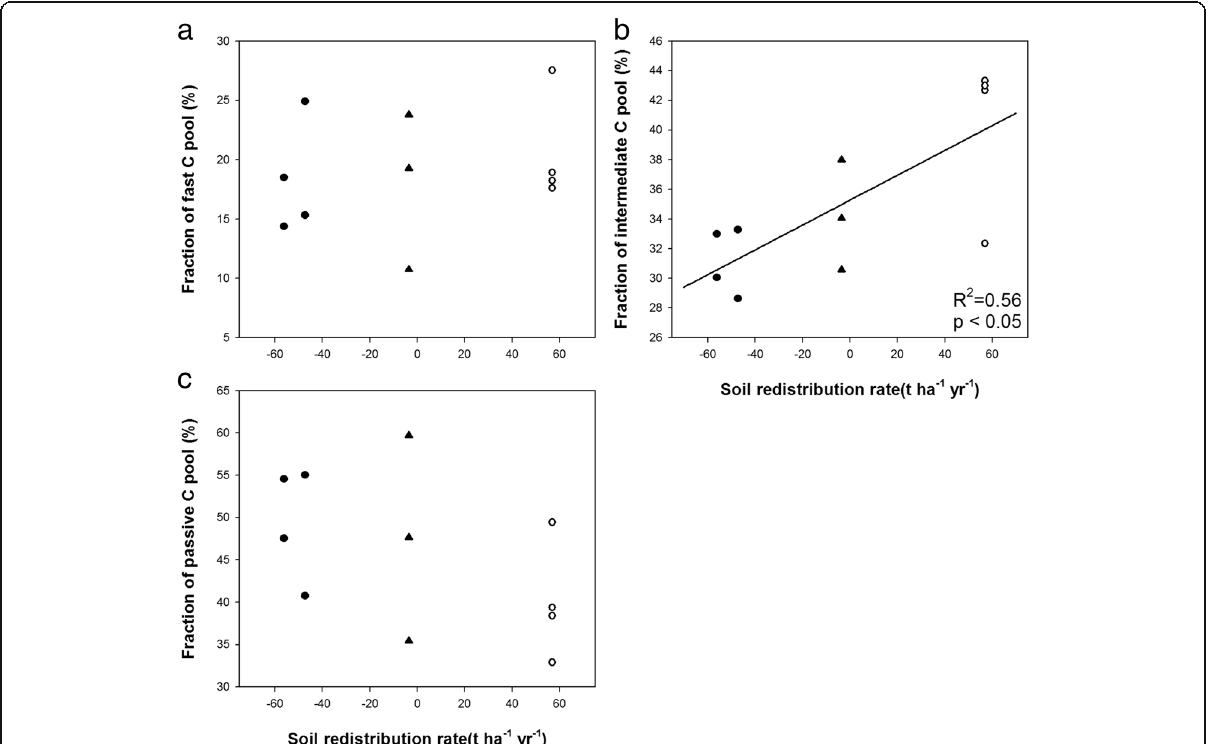
Fig. 6 The changing contribution of the fast C fractions ( a ), the intermediate C fractions ( b ) and the passive C fractions ( c ) along the slope (non- eroding position: triangle, eroding position: solid dots, depositional position: hollow circles). The fractions of the intermediate C ( b ) are significant and high (p < 0.05) at the depositional position (high soil redistribution